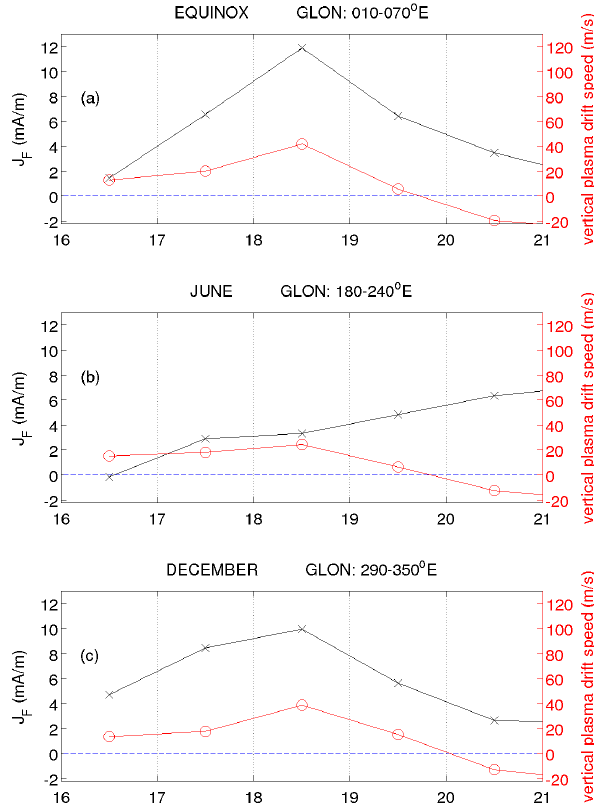
Fig. 1. Local time variation of the dynamo current density (black crosses) and vertical plasma drift (red circles) for the three sea- sons. For the equinox, June and December solstices only data in 10–70 ◦ , 180–240 ◦ and 290–350 ◦ E GLON are considered, respec- tively, where the solar terminator is best aligned with the magnetic meridian and PRE amplitudes become